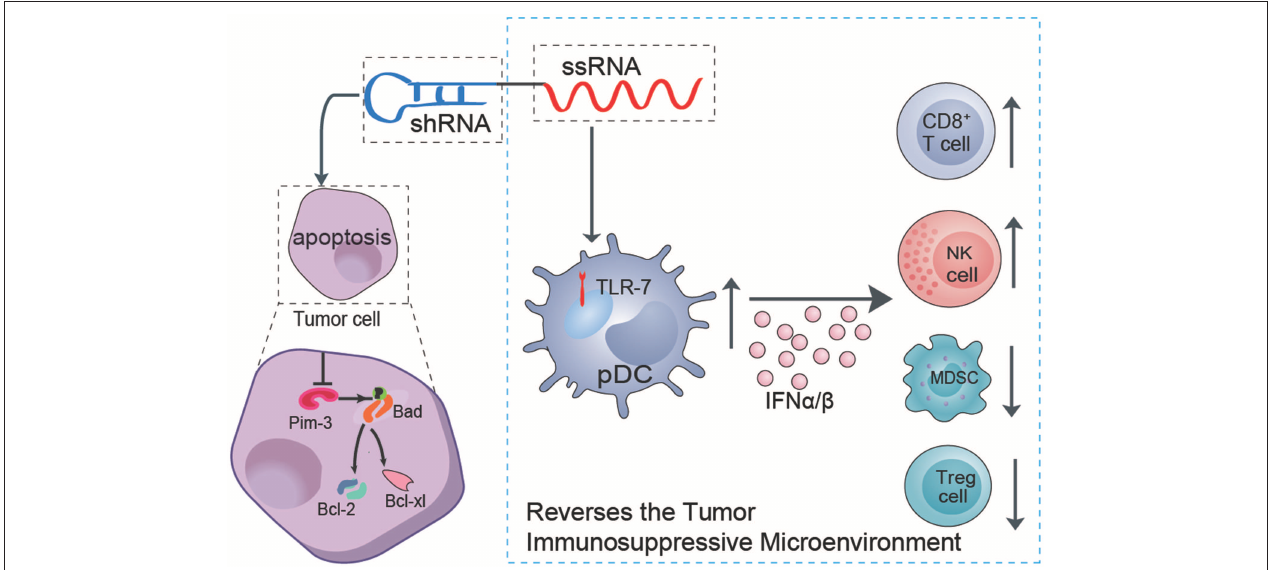
FIGURE 7 | Schematic illustration of the role of the dual ssRNA-Pim-3-shRNA vector with both Pim-3-silencing and immunostimulatory effects for inhibiting melanoma growth. Therapy with the dual-function vector not only promotes the apoptosis of B16F10 melanoma cells by silencing Pim-3 but also activates pDCs by ssRNA, leading to secretion of a large amount of type I interferon, enhanced activation of NK cells and CD8 + T cells, and reduced percentages of Tregs and MDSCs. Combined, these effects reverse the tumor immunosuppressive microenvironment and inhibit the growth of melanoma cells. ssRNA, single-stranded RNA; shRNA, small hairpin RNA; pDCs, plasmacytoid dendritic cells; NK, natural killer; Treg, regulatory T cell; MDSCs, myeloid-derived suppressor